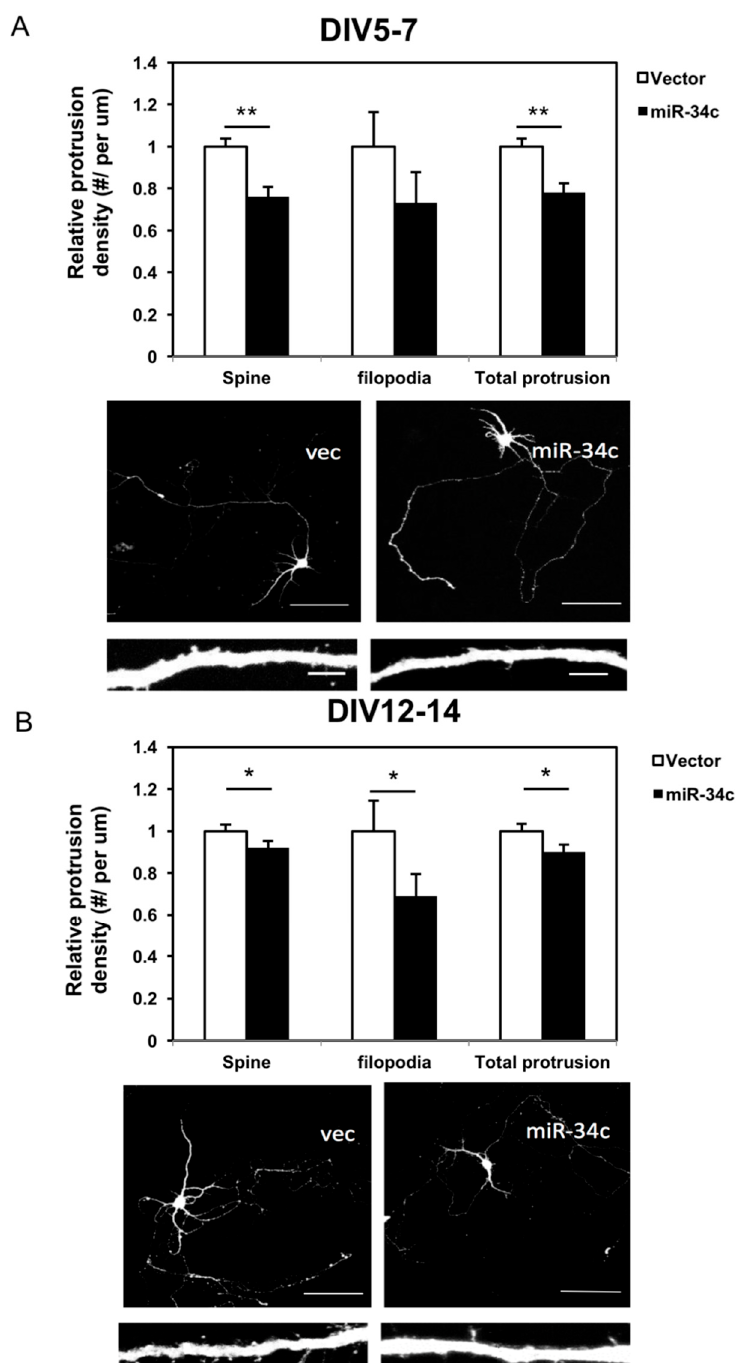
Figure 4. We observed that miR-34c lowered dendritic spine density and total protrusion density. Quantification of the protrusion density of neurites including mature spines, immature filopodia, and the summation of both using immunostaining on the ( A ) DIV 7 (Scale bar of upper panel = 100 μ m; lower panel = 5 µ m) and ( B ) DIV 14 in miR-34c and vector-transfected (vec) cells ( n = 28 in each group) was conducted under 100 × magnification and calculated using a two-tailed Student’s t -test (* p < 0.05, ** p < 0.01). Scale bar of upper panel = 100 μ m; lower panel = 5 μ m.